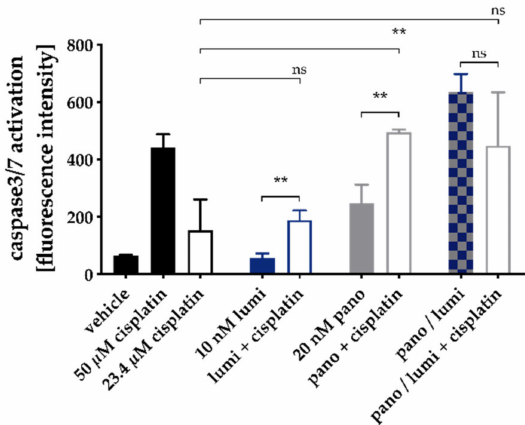
Figure 4. Caspase 3 / 7 activation by single treatment and combinations of panobinostat, luminespib, and cisplatin in A2780CisR cells. A2780CisR cells were preincubated with panobinostat and / or luminespib (lumi) for 48h. Cisplatin (23.4 µ M, corresponding to the IC 50 ) or bu ff er control were added for a further incubation period of 24 h. Caspase 3 / 7 activation was analyzed by ArrayScan XTI. Cisplatin 50 µ M